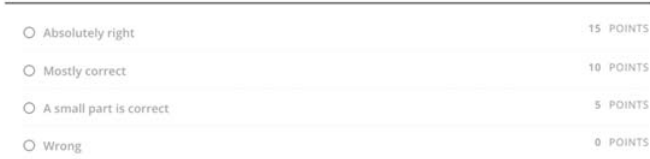
Figure 6. Types of questions and grades for each category.